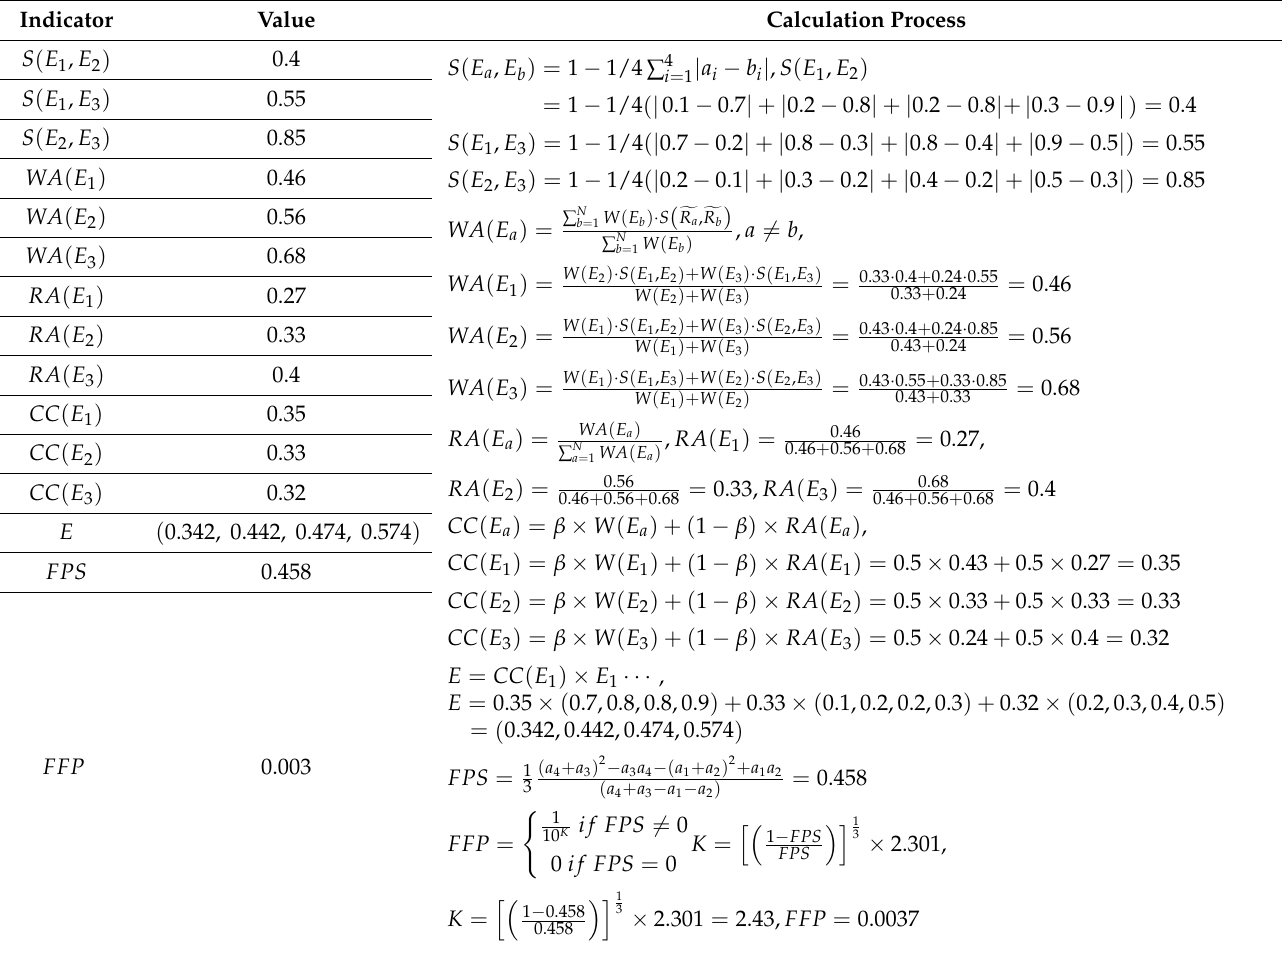
Table 5. The detailed calculation process of the prior probability of node C 21